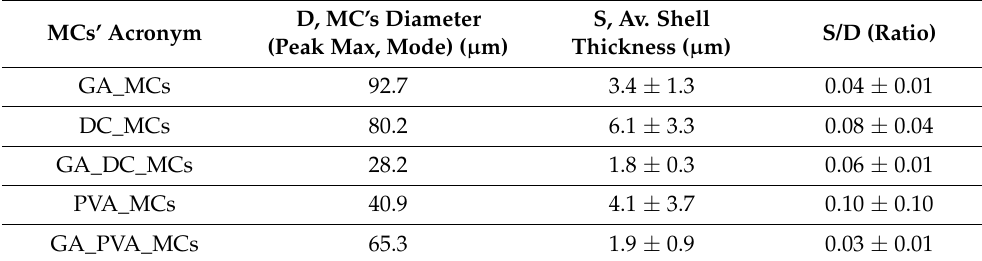
Table 2. MCs’ diameter, average shell thickness (s) and S/D